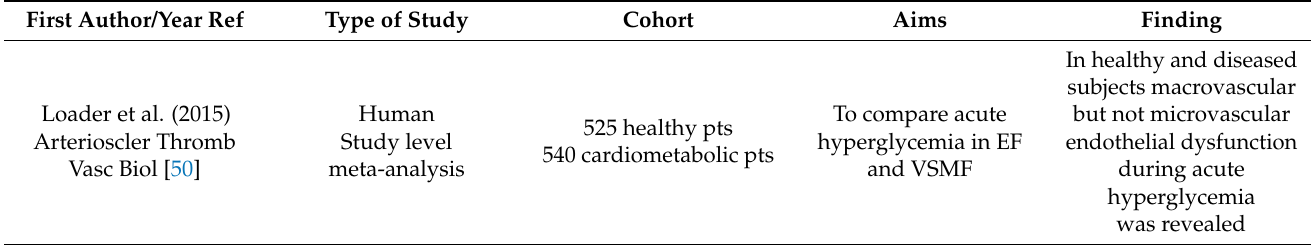
Table 3 highlights the included studies relating to diabetes. Table 3. Characteristics of the Included